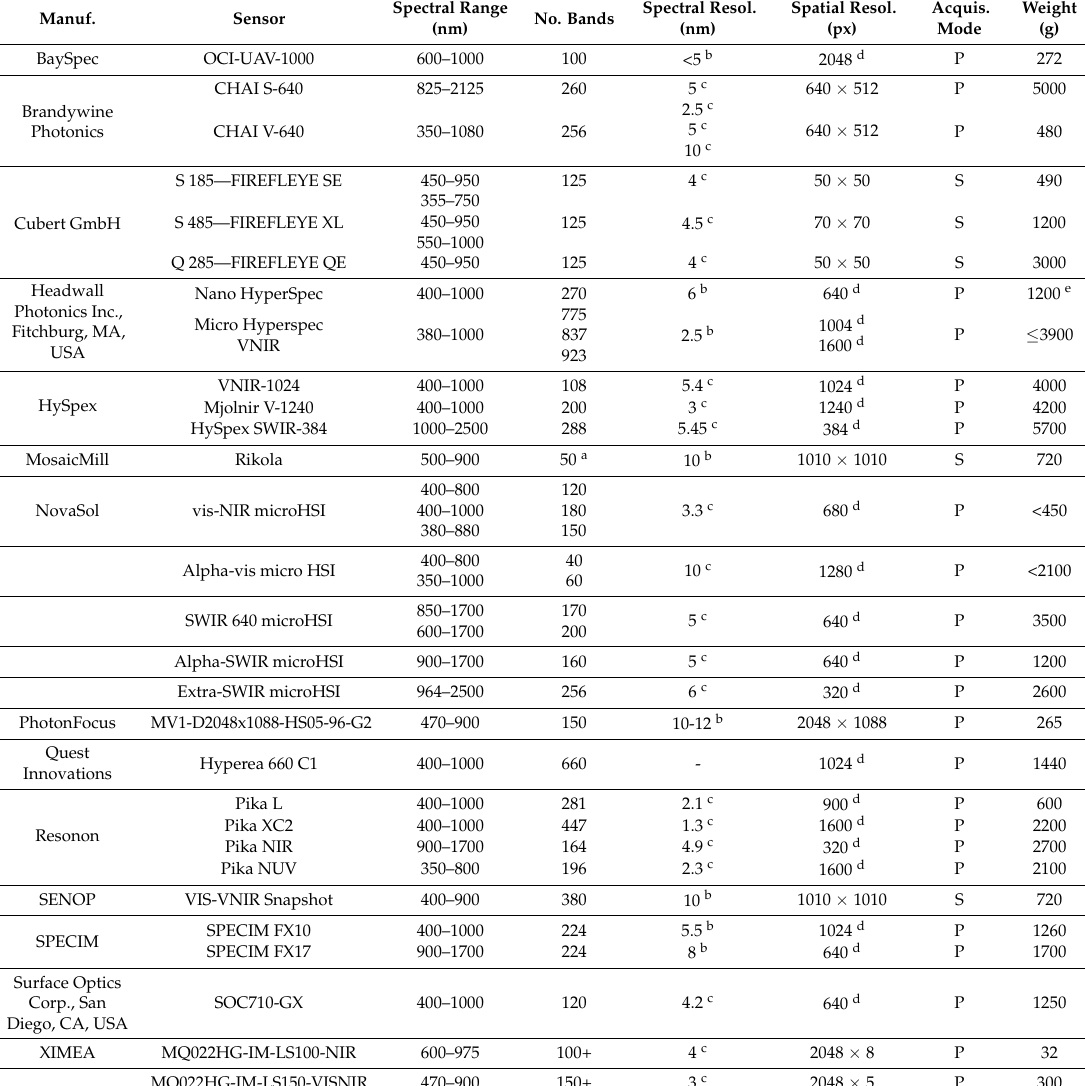
Table 2. List of hyperspectral sensors (and respective characteristics) available for being coupled with